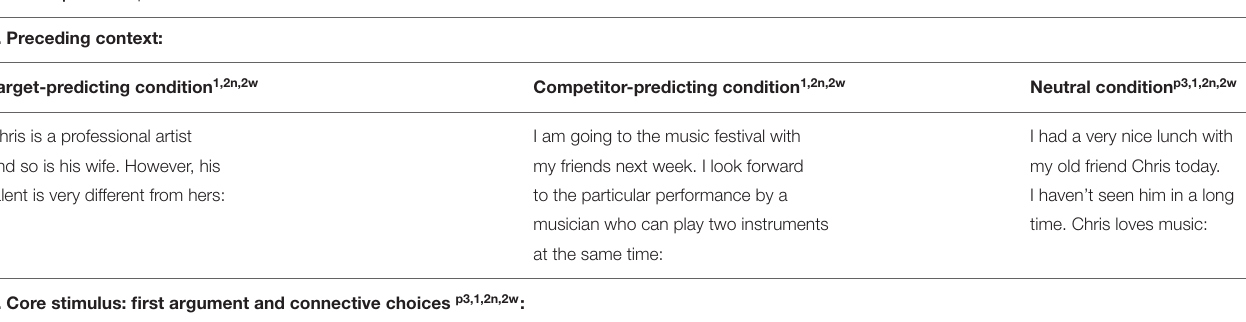
TABLE 4 | An example of a stimulus in various